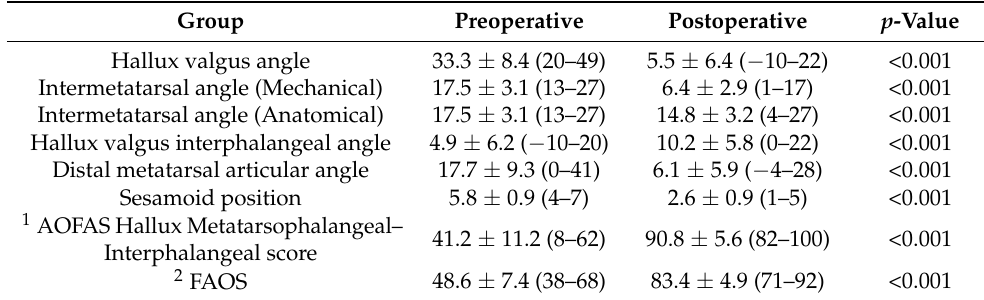
Table 2. Comparison of radiologic angular changes.